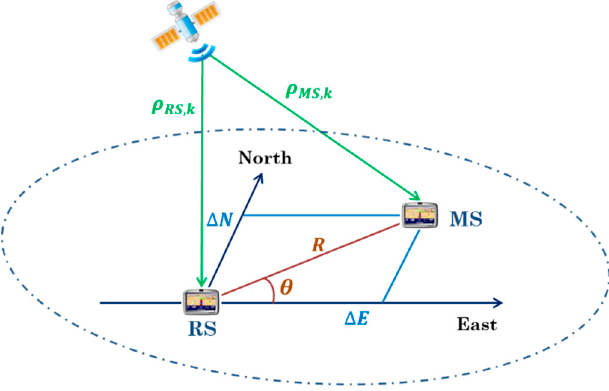
Figure 2. Mapping of the MS code delay search to position/clock bias and pseudorange domains.